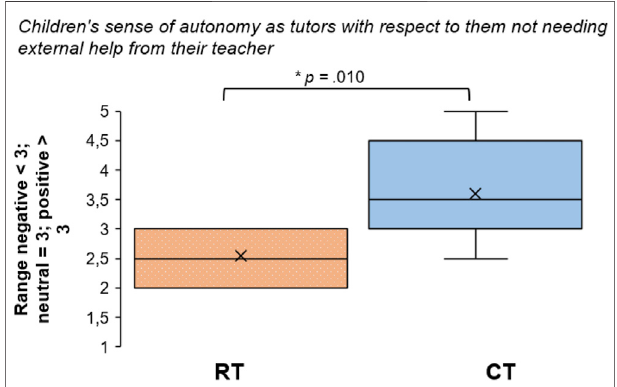
FIGURE 5 | Box plots showing comparisons of composite scores for inverted items regarding need for teacher help, hence signifying the tutor ’ s sense of autonomy for the RT and the CT (x = means; lines = medians; whiskers = ranges).